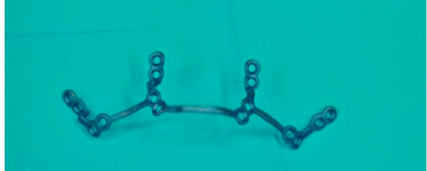
Figure 4. Cutting guide for the upper jaw.